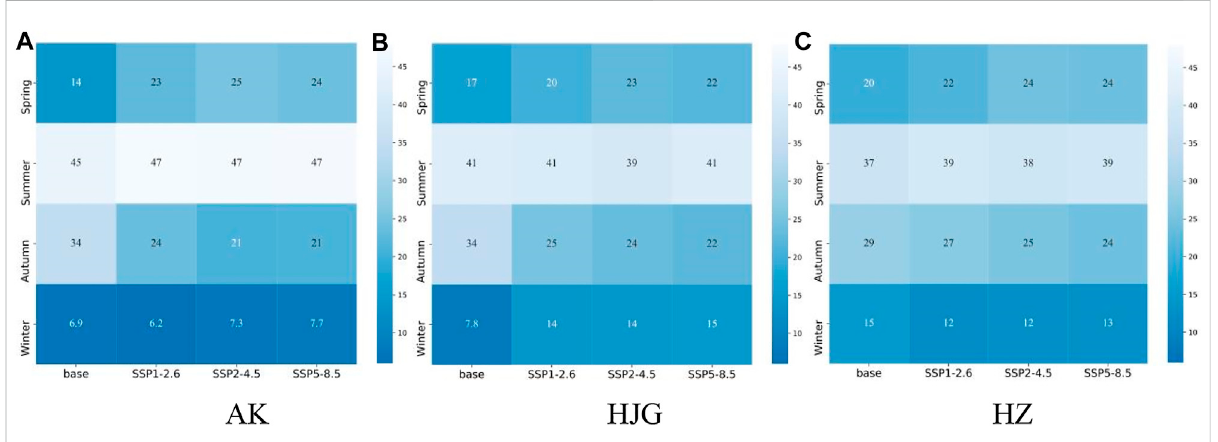
FIGURE 12 DifferenceofseasonalrunoffproportionofthreesectionsunderNESM3moderelative(%). (A – C) aretheseasonalrunoffdistributionofAK,HJG and HZ under SSP1-2.6, SSP2-4.5 and SSP5-8.5 compared with the historical